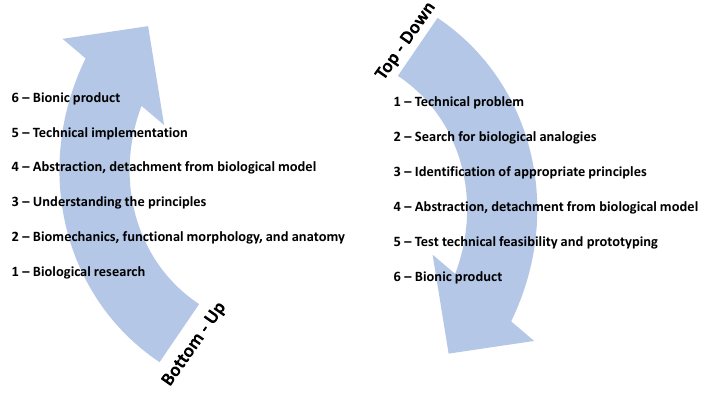
Figure 1. Biomimicry approaches (adapted from